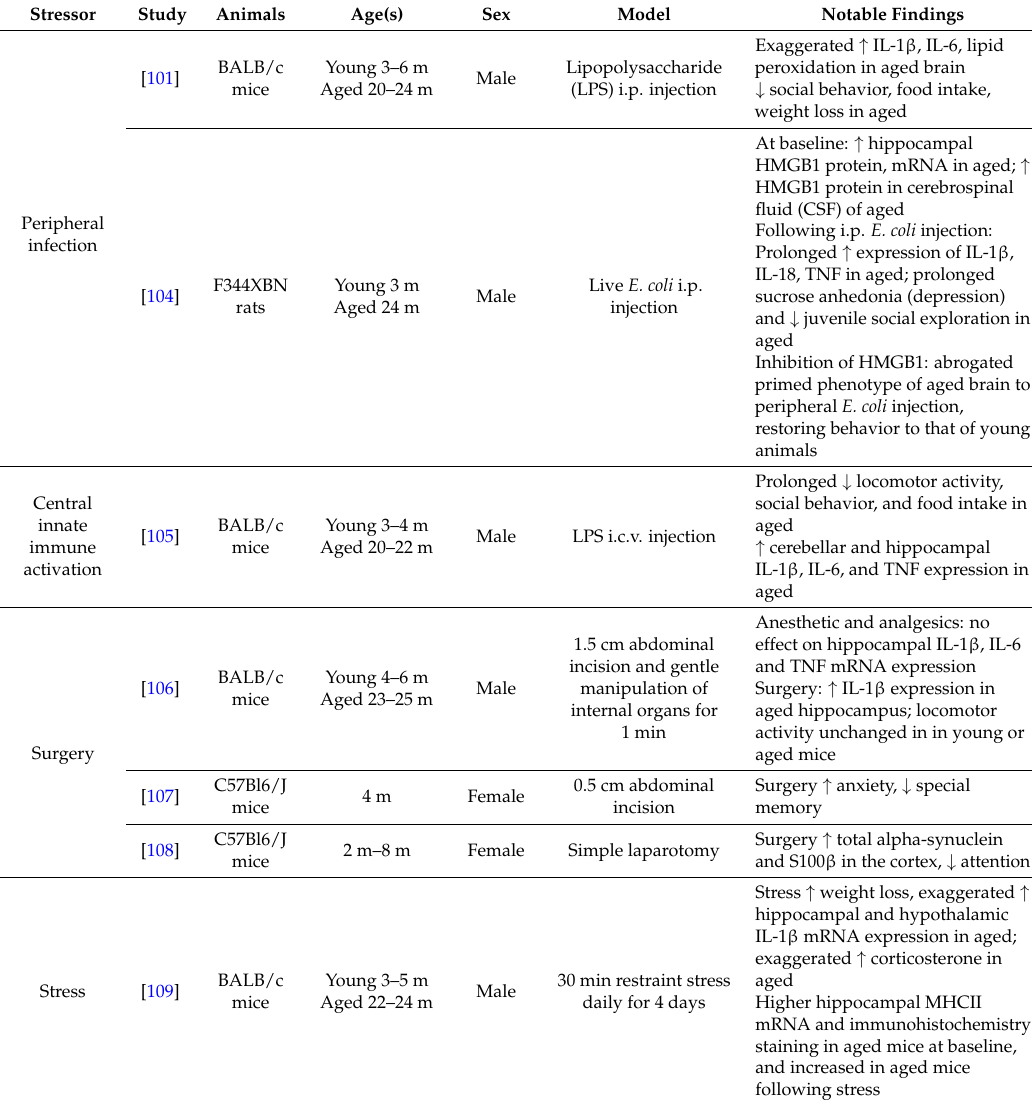
Table 1. Summary of animal studies comparing young and aged differences in cognitive function following stress. Various models of stress and immune system activation examined in young and aged animals show that aged animals have an exaggerated neuroinflammatory response and prolonged behavioral deficits compared to young animals. ( ↑ = “elevated,” ↓ =